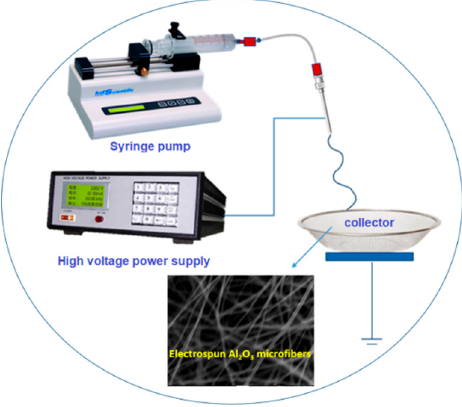
Figure 1. Schematic illustration of electrospinning preparation of as-spun fiber.